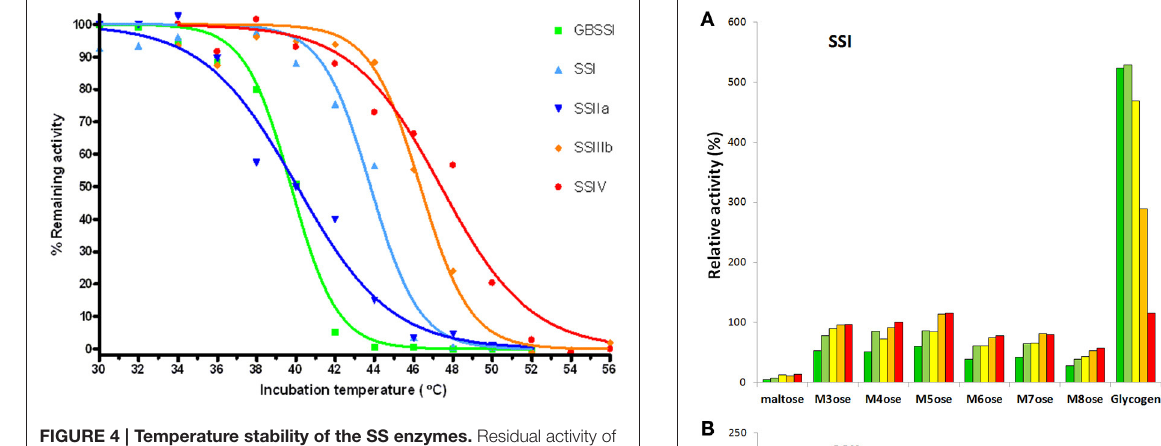
FIGURE 4 | Temperature stability of the SS enzymes. Residual activity of SS samples after incubation at the indicated temperatures. Solid lines are sigmoidal fits to the experimental data.